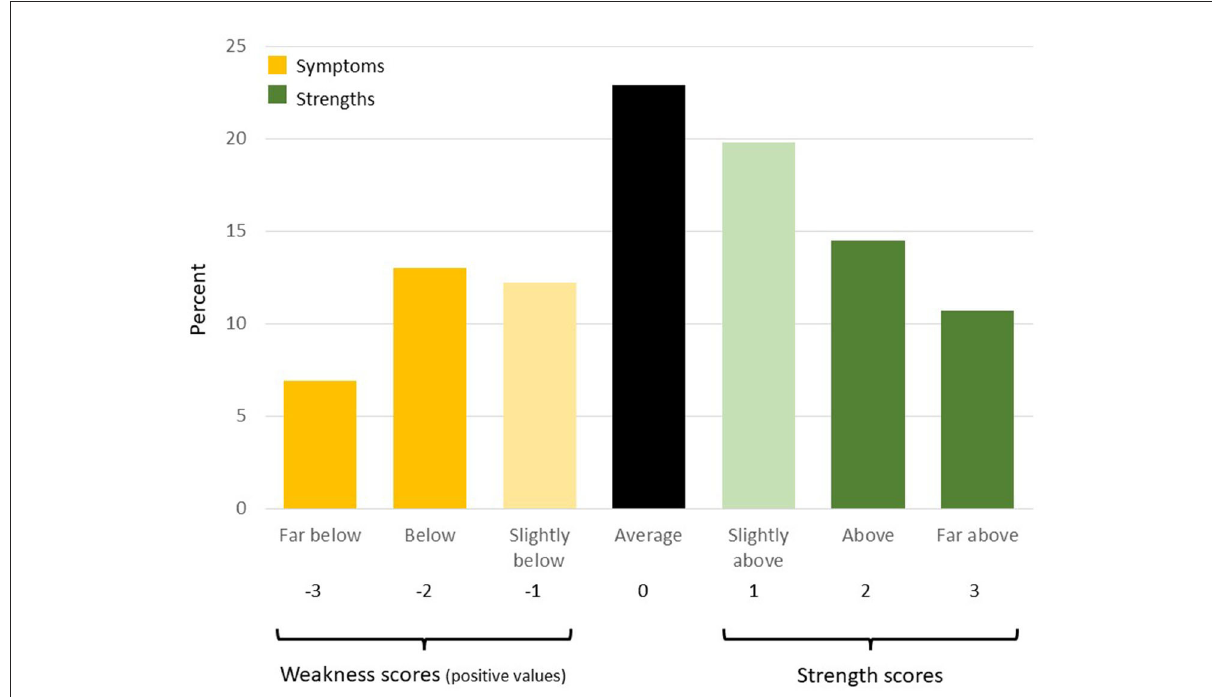
FIGURE1 Strengths and weaknesses from SWAN scale. Creation of strength and weakness scores, symptoms and strengths, illustrated using the distribution (%) of responses to the item “Engage in tasks that require sustained mental effort” in the ASD sample. Scores that do not fall within the regions shown as “strength scores” or “weakness scores” are set to 0. We take the absolute value of weaknesses when calculating weakness scores so that slopes in the linear regression models retain a consistent meaning across both strength and weakness scores (positive slope represents increase in dependent outcome with more strengths or more